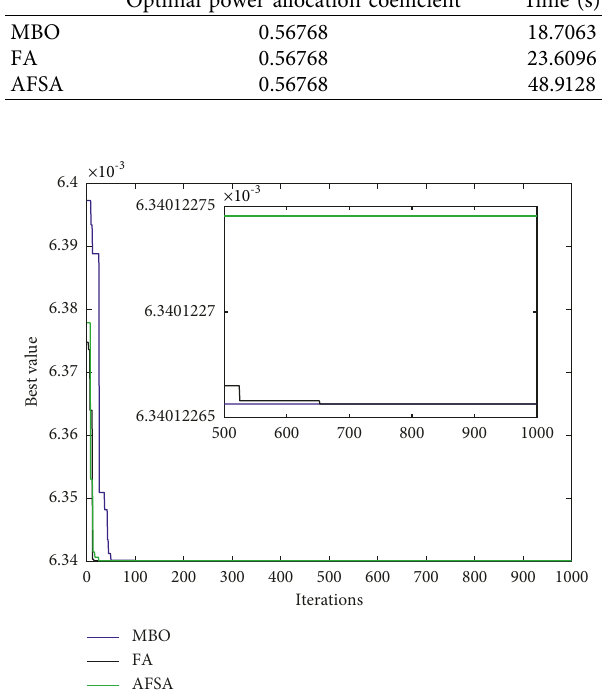
Figure 5: The iterative optimization process of the three algorithms.